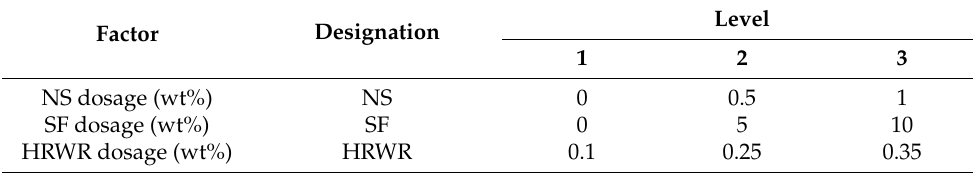
Table 4. Factors and their levels for this